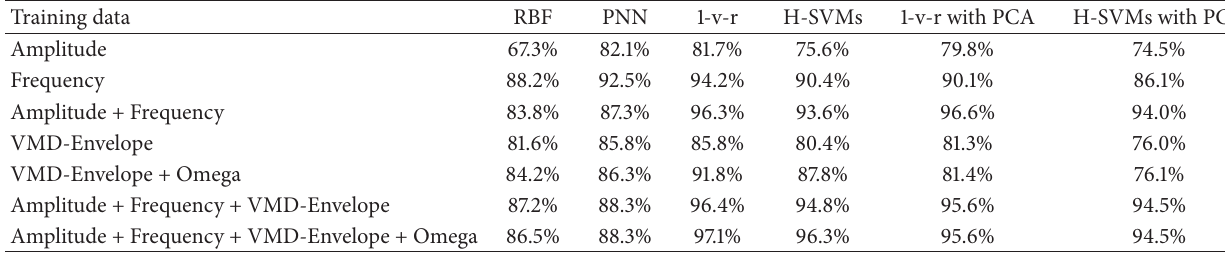
Table 4: Classification results with different training